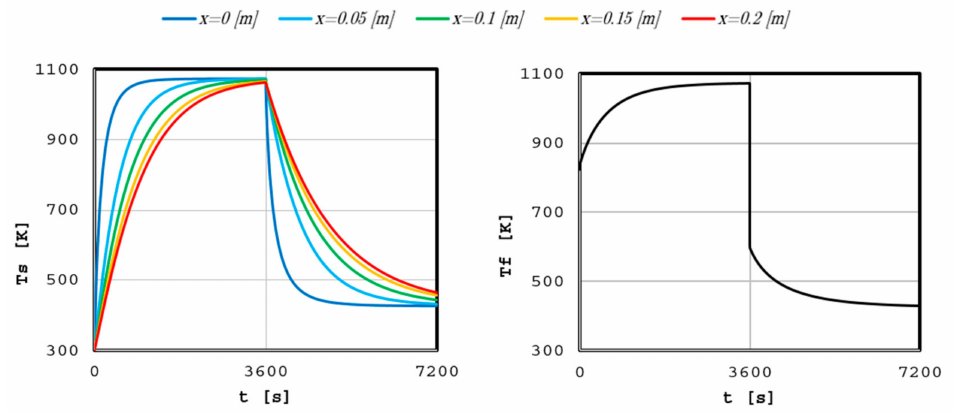
Figure 11. Charging and discharging of the designed thermal energy storage (TES).